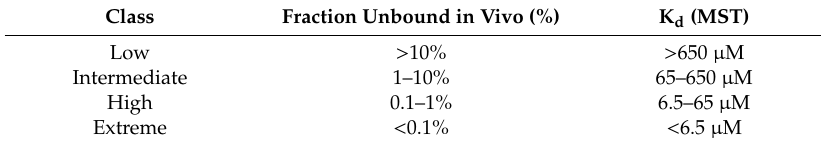
Table 4. Classification of compounds based on the traditional assay and MST results, according to the classes in Table 3. The calculated in vitro and in vivo fractions unbound (%) are presented as a reference. Compound